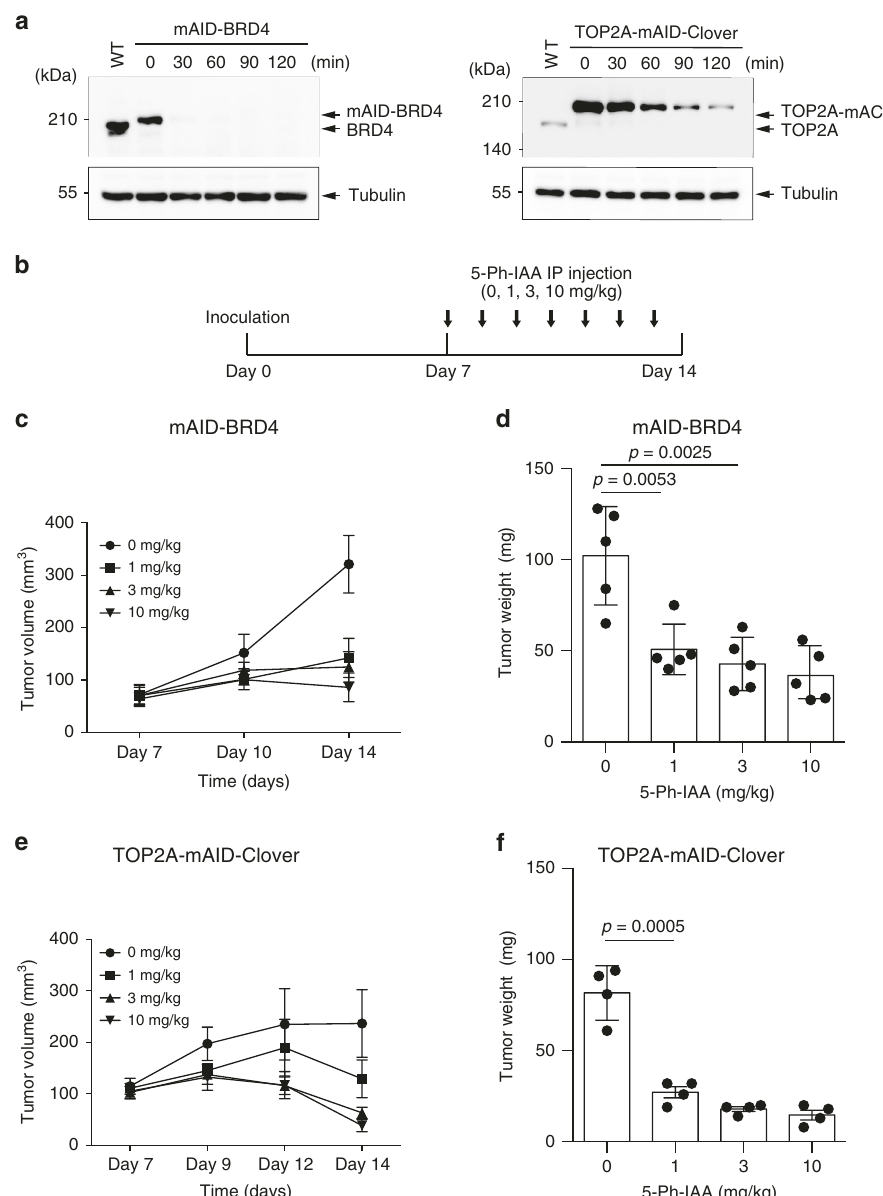
Fig. 5 Xenograft tumour suppression by the AID2 system. a mAID-BRD4 or TOP2-mAC HCT116 cells expressing OsTIR1(F74G) were treated with 1 µ M 5-Ph-IAA and sampled at the indicated time points. Proteins were separated and detected using a speci fi c antibody. Tubulin was used as a loading control. We repeated this experiment twice and obtained similar results. b Experimental time-course diagram showing the xenograft assay. c Graph showing mAID-BRD4 xenograft tumour growth. Tumour volume was checked on the indicated days. Data are presented as mean values± SD ( n = 5 animals). d Graph showing the tumour weight on day 14. mAID-BRD4 xenograft tumour was taken and weighed. Data are presented as mean values± SD ( n = 5 animals, two-tailed t -test). e Graph showing TOP2A-mAC xenograft tumour growth. Tumour volume was checked on the indicated days. Data are presented as mean values± SD ( n = 4 animals). f Graph showing the tumour weight on day 14. TOP2A-mAC xenograft tumour was taken and weighed. Data are presented as mean values ± SD ( n = 4 animals, two-tailed t